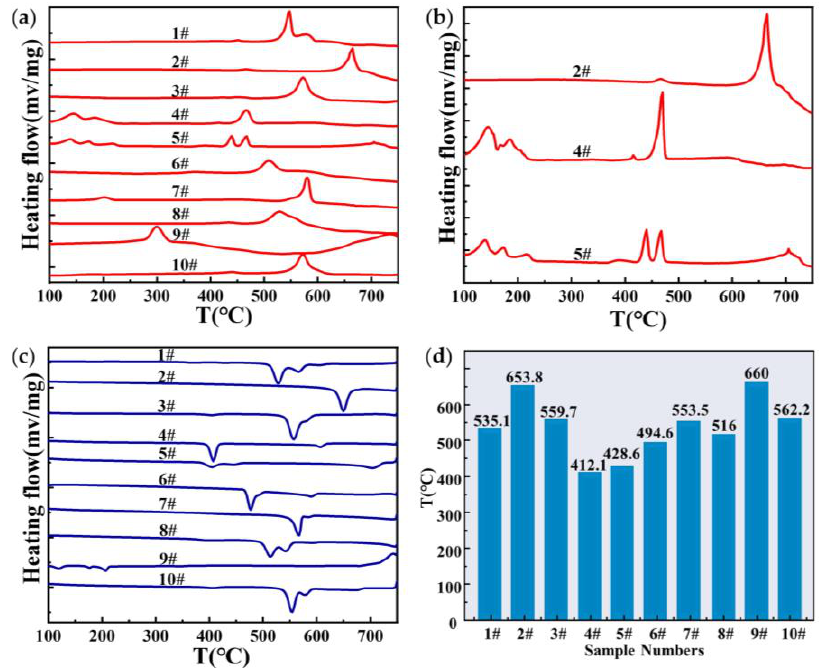
Figure 1. The results of DSC: ( a ) DSC heating curves of fluxes #1 – #10, with the rate of 5 K/min, in an atmosphere of nitrogen; ( b ) enlarged view of the heating curves of fluxes #2, #4, and #5; ( c ) DSC cooling curves of fluxes #1 – #10, with the rate of 5 K/min, in an atmosphere of nitrogen; ( d ) the melting points of the fluxes.